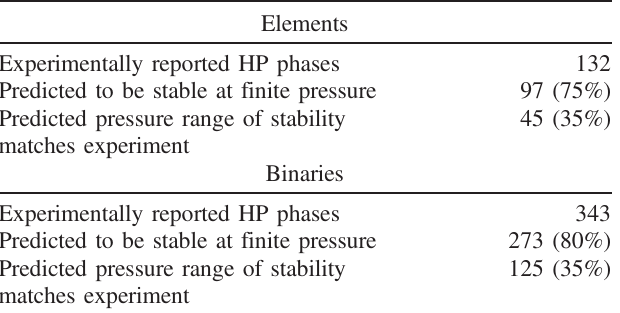
TABLE I. Accuracy of the linear enthalpy model in predicting the stability (at some finite pressure) of experimentally reported elemental and binary high-pressure